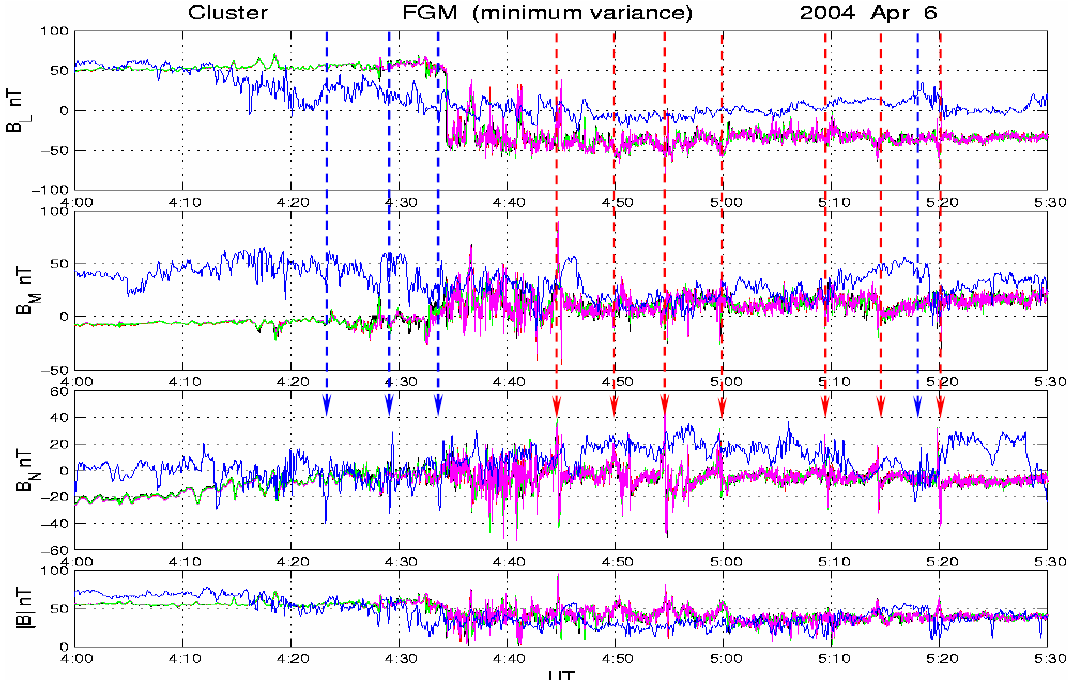
Fig. 3. A multi spacecraft plot of the magnetic field in LMN (MVA) coordinates. The analysis of Cluster gives: [n=0.720 0.163 0.675, m= − 0.379 − 0.722 0.579, l= − 0.582 0.672 0.458], λ =5 and TC-1 gives [n=0.233 − 0.682 − 0.694, m= − 0.679 − 0.625 0.385, l=0.696 − 0.381 0.609] , λ =3 (components in GSM). Clear FTEs are observed at Cluster (all spacecraft) with +/ − polarity. The FTEs at TC-1 are less clear, but most have − /+ (reverse)